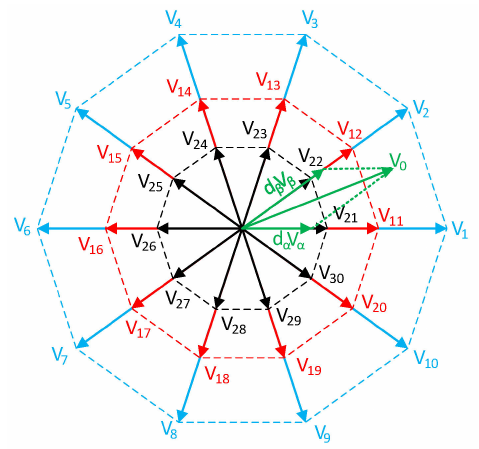
Figure 3. Output voltage decagon with all